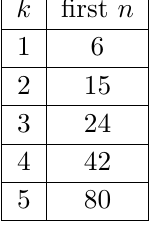
Table 4 . Table showing the smallest values of n for which T C ( S n ). We give the n values for k from 1 to 5. This table was generated by computing the content polynomials for each irrep R at (cid:12)xed n . Degeneracies in the content polynomials translate to degeneracies in the normalized